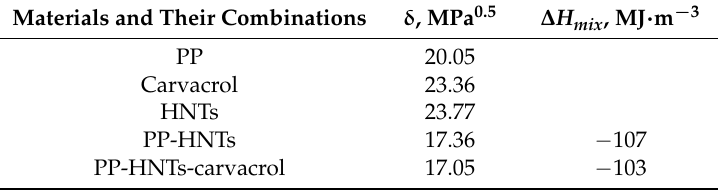
Table 3. Solubility parameters of PP, HNTs and carvacrol and their enthalpy of mixing, calculated using molecular dynamics simulation.